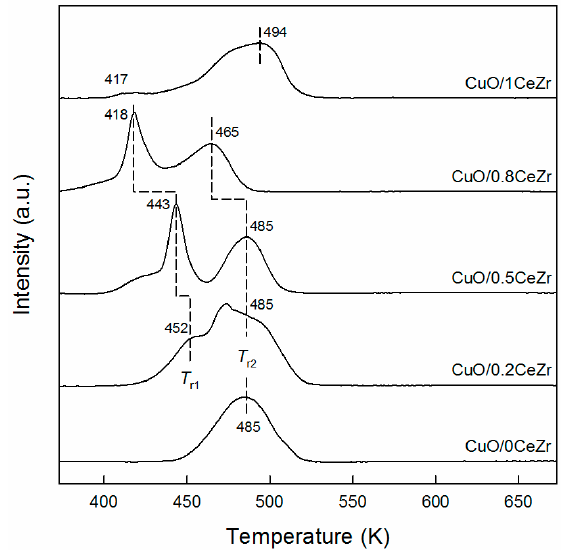
Figure 2. H 2 temperature-programmed reduction profiles of CuO/ x CeZr samples.